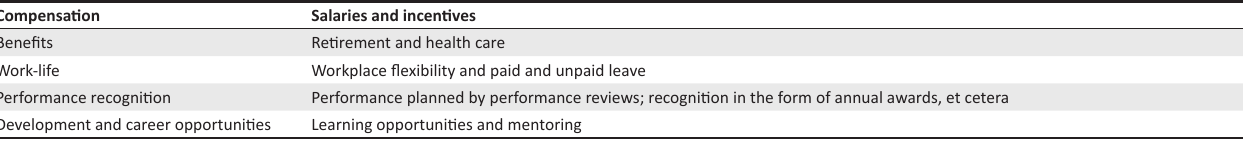
TABLE 2: Five elements and examples of the model for total reward strategy.